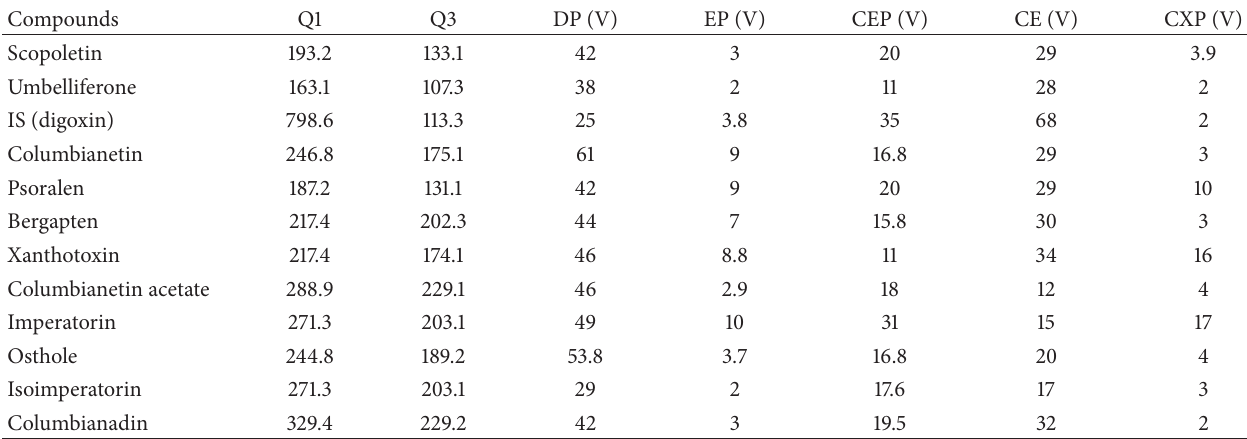
Table 1: Retention time, MS/MS fragment ions, declustering potential (DP), and collision energy (CE) of the 11 coumarins compounds in Radix Angelicae Pubescentis.